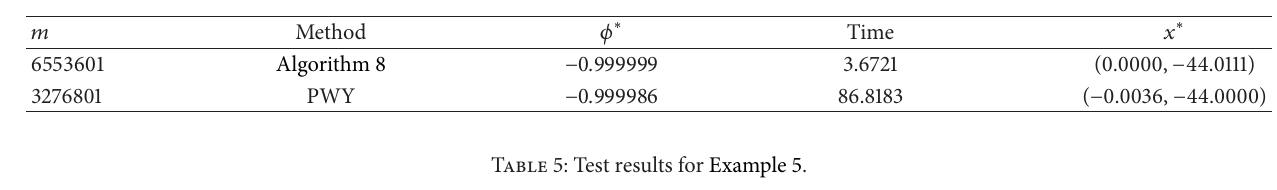
Table 4: Test results for Example 4.